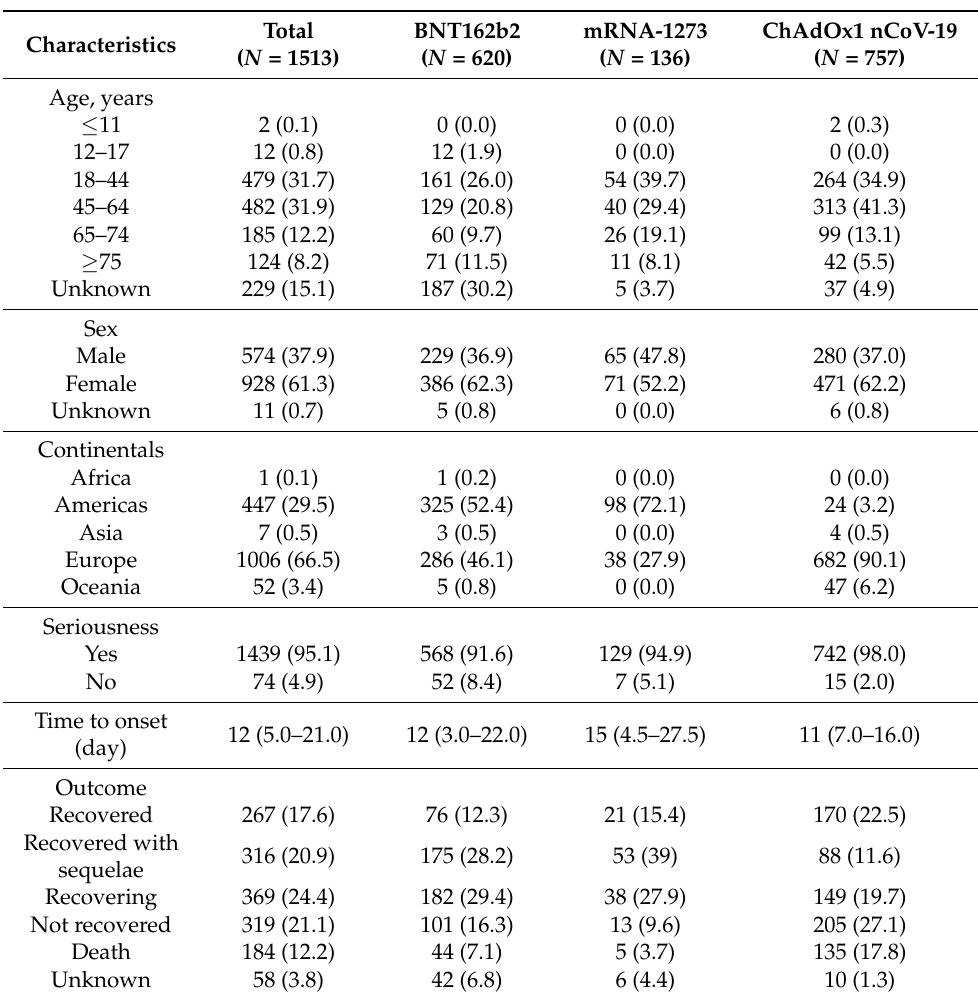
Table 1. Demographics and characteristics of reported cases of cerebral venous thrombosis according to type of COVID-19